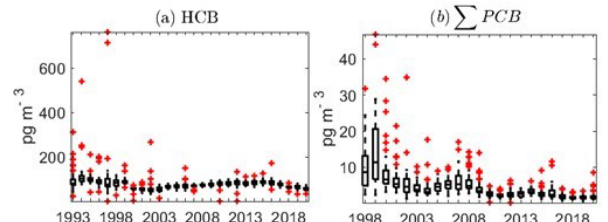
Figure 16. Boxplot time series (box top and bottom: 75th and 25th percentiles, respectively; horizontal bar: median; outliers: red crosses) of (a) hexachlorobenzene (HCB) from 1993 to 2019 and (b) the sum of seven polychlorinated biphenyls (PCBs 28, 52, 101, 118, 138, 153, 180) from 1998 to 2019, at the Zeppelin